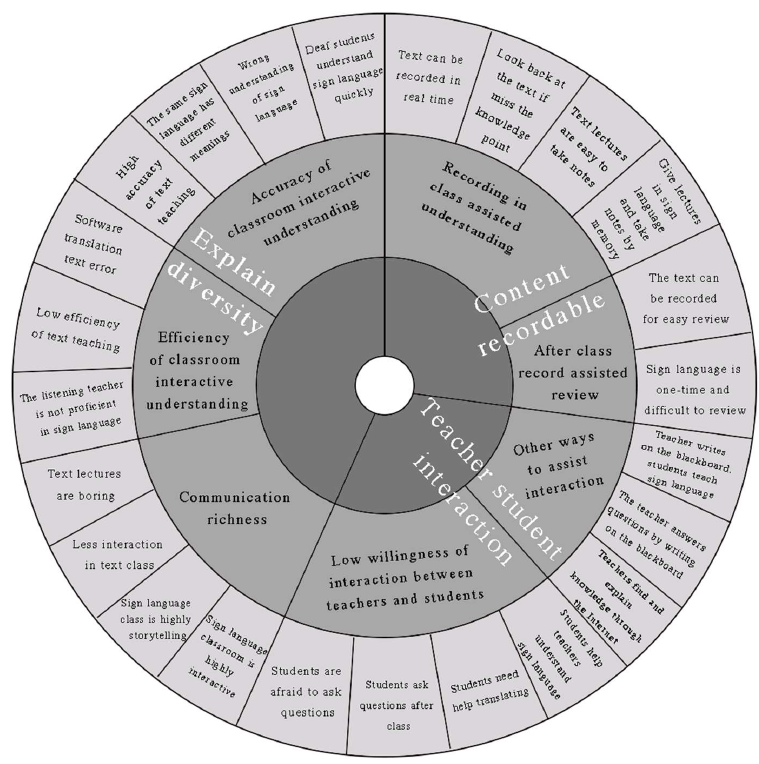
Figure 1. Hierarchical content of each node in the coding system.